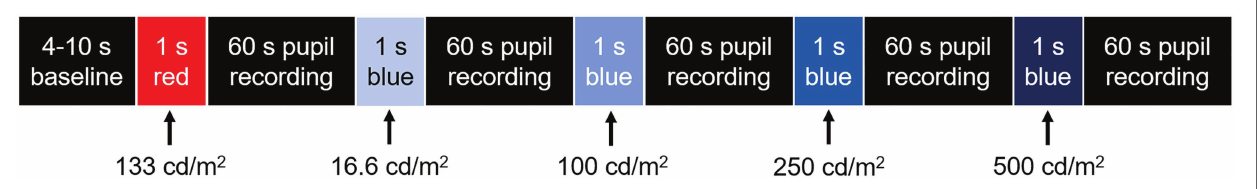
FIGURE 1 | Pupillometry protocol. Baseline pupil diameter was recorded in the dark for 4–10 s. A 1 s red stimulus (133 cd/m 2 ) and four increasing intensities of 1 s blue stimuli (16.6, 100, 250, and 500 cd/m 2 ) were presented, with a 60 s interstimulus